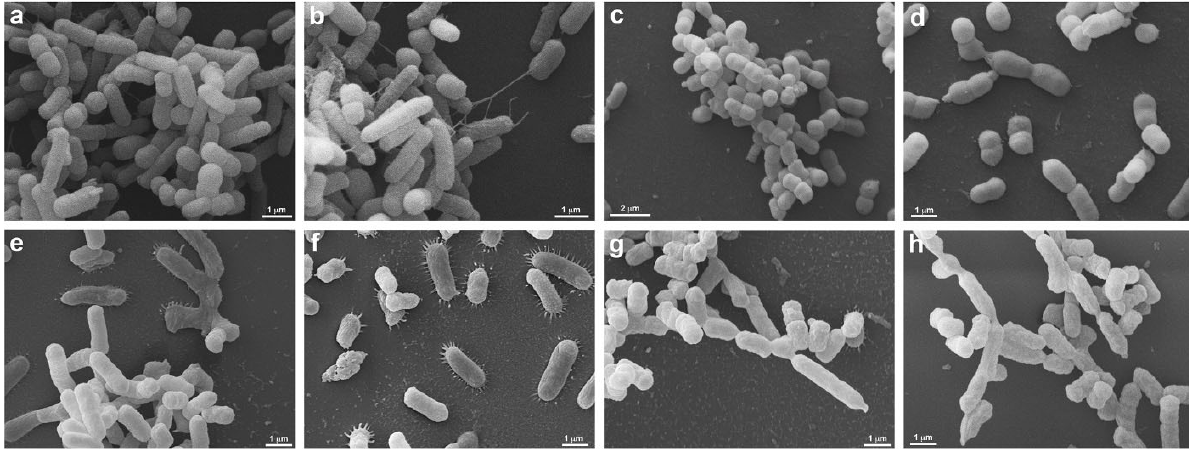
Figure 6. Morphological analysis of UV-C treatment (2 s) by Scanning Electron Microscopy. S. enterica (ATCC 10708) ( a – d ) and E. coli (ATCC 25922) ( e – h ) are seen without ( a , b , e , f ) and under UV-C treatment ( c , d , g , h ). Untreated S. enterica ( a , b ) are elongated, presenting many pili-like appendages emerging from different regions of the cell body. Note that the cells form large aggregates, where more pili-like appendages are seen contacting each other ( a ). After treatment with UV-C, the S. enterica ( c , d ) still presents the same morphology, but there is a decrease in pili-like appendages and the formation of cell aggregates ( c , d ). Both, untreated ( e , f ) and treated ( g , h ) E. coli present the same morphology, the cells are elongated, and less pili-like appendages are observed ( e – h ). There is no difference between untreated and treated E. coli .